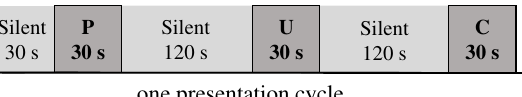
Figure 6. Presentation cycle of auditory stimulation (2). P, personal ultrasonic stimulus; U, ultrasonic stimulus that was unrelated to the subject; C, ultrasonic stimulus that was common to all